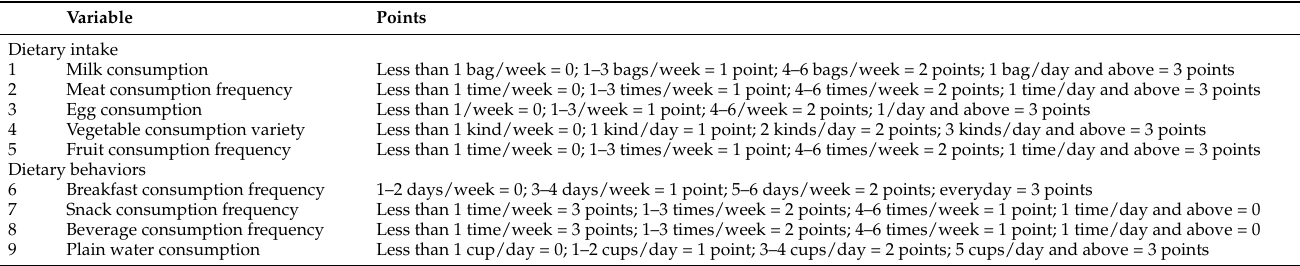
Table 1. Points assigned to each variable of dietary intake and dietary